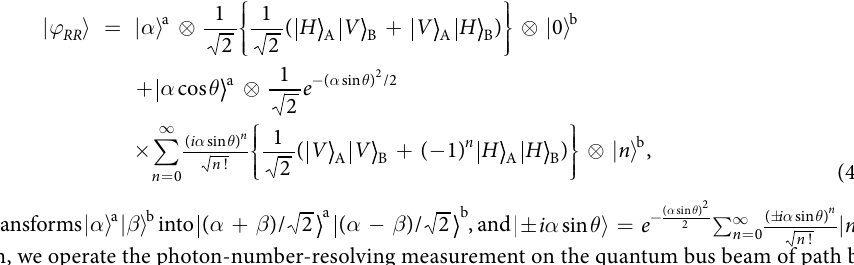
κ γ  g ( , ) with small γ (about several μ eV) for ω ω = − ϕ ω ) = 0, and ϕ ω ) = ± π /2 through adjustment of the frequencies between the external field and cavity mode rh ( r0 ( ), and by omitting the leaky modes ˆ S ( ω ω κ − =  /2 c experimental parameters g / κ = 2.4 and κ s = 0 (negligible) with ω − ω c = κ /2 and γ / κ = 0.1, the reflection operator ω ˆ R( ) in Eq. 2 can be expressed as